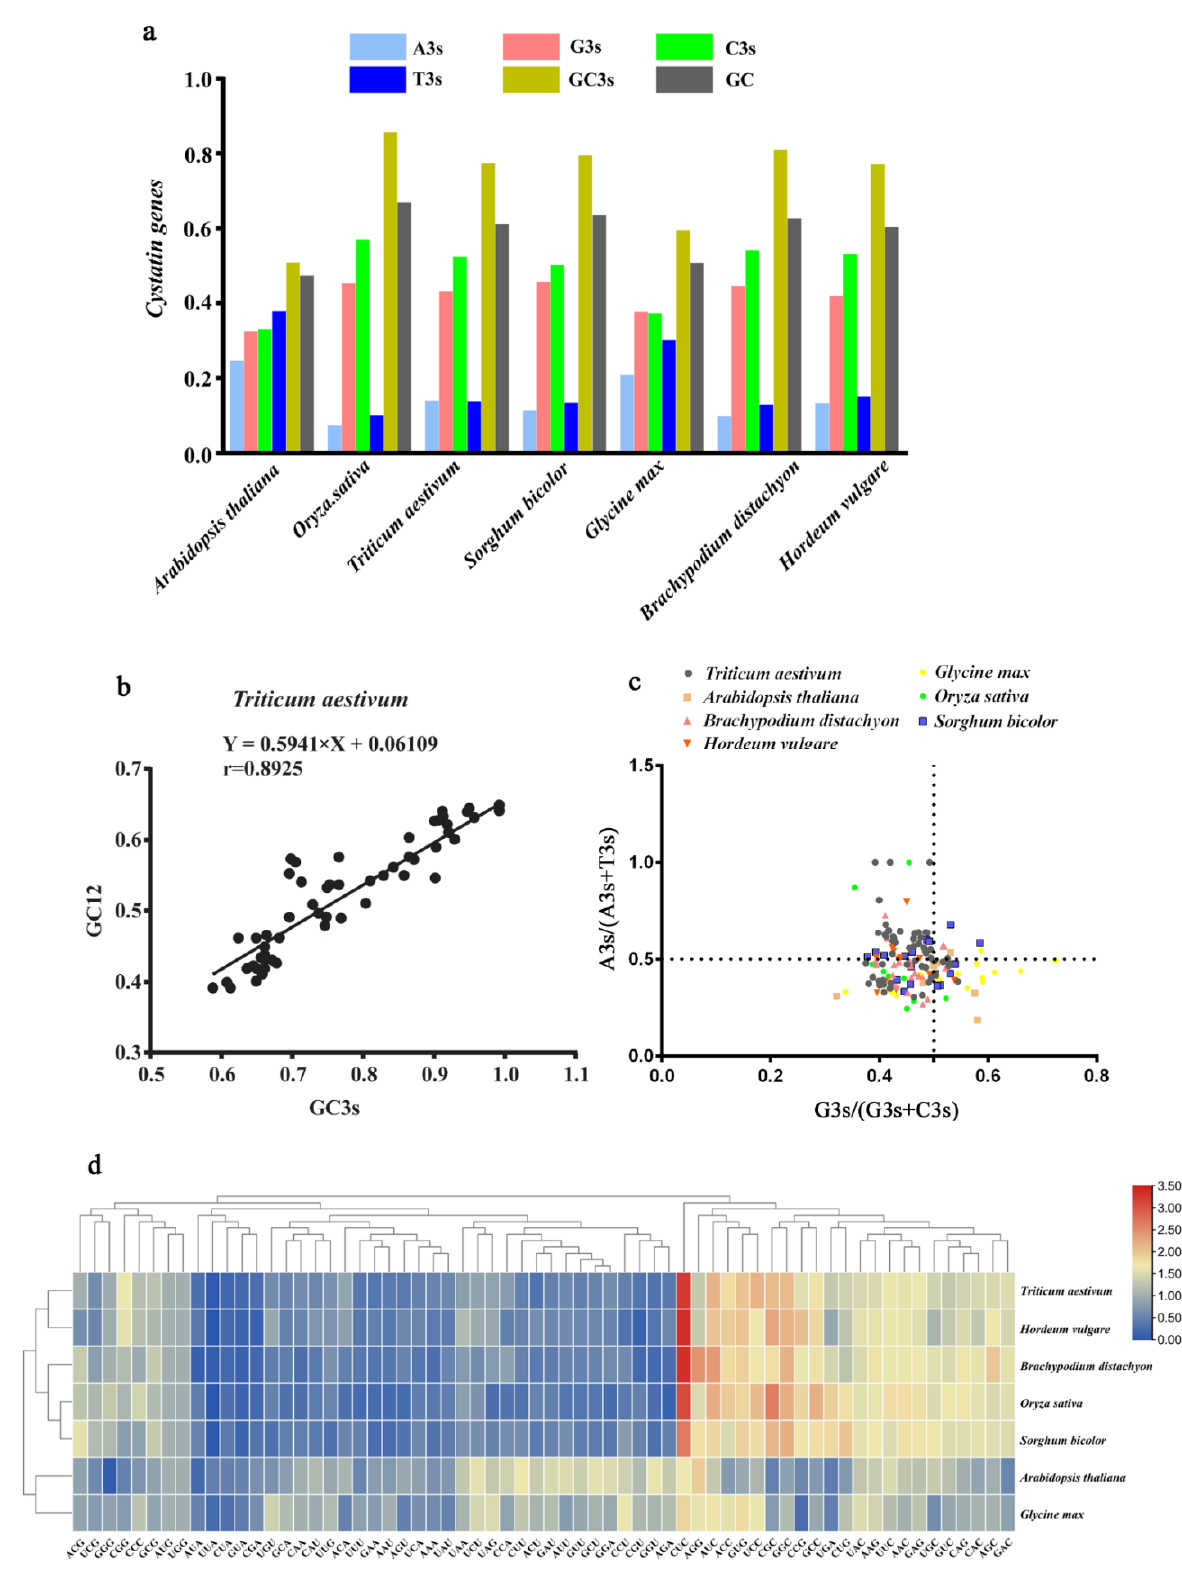
Figure 5. Codon usage pattern analysis. ( a ) Vertical axis representing the contents of various bases at the third position of the codons in seven species. ( b ) Neutrality plot analysis of TaCystatin CDS sequences. ( c ) Parity rule 2 (PR2) analysis of cystatin CDS sequences in seven species. ( d ) Heatmap showing relative synonymous codon usage (RSCU) values of cystatin CDS sequences in seven species. Blue-to-red color indicates low-to-high RSCU values of codons.